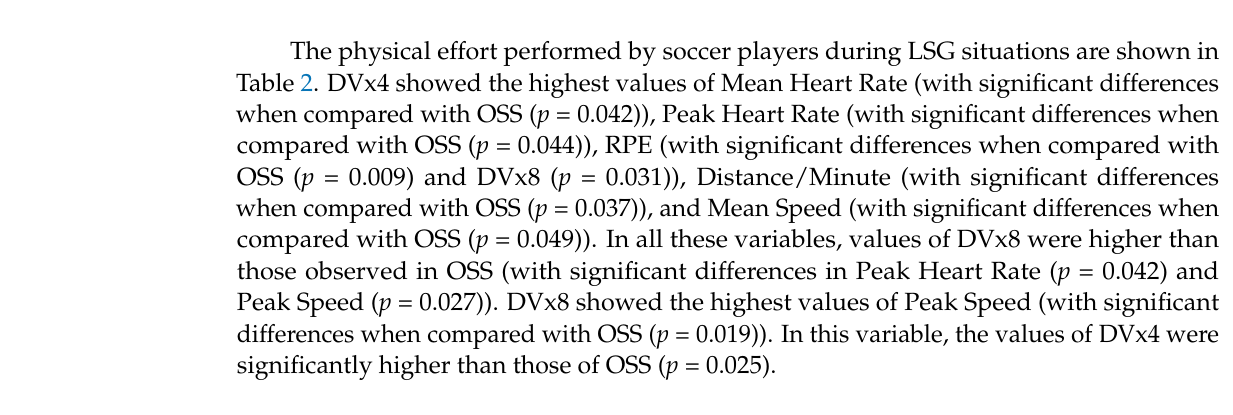
Table 2. Physical efforts covered and reported by players. A comparison between experimental ses-